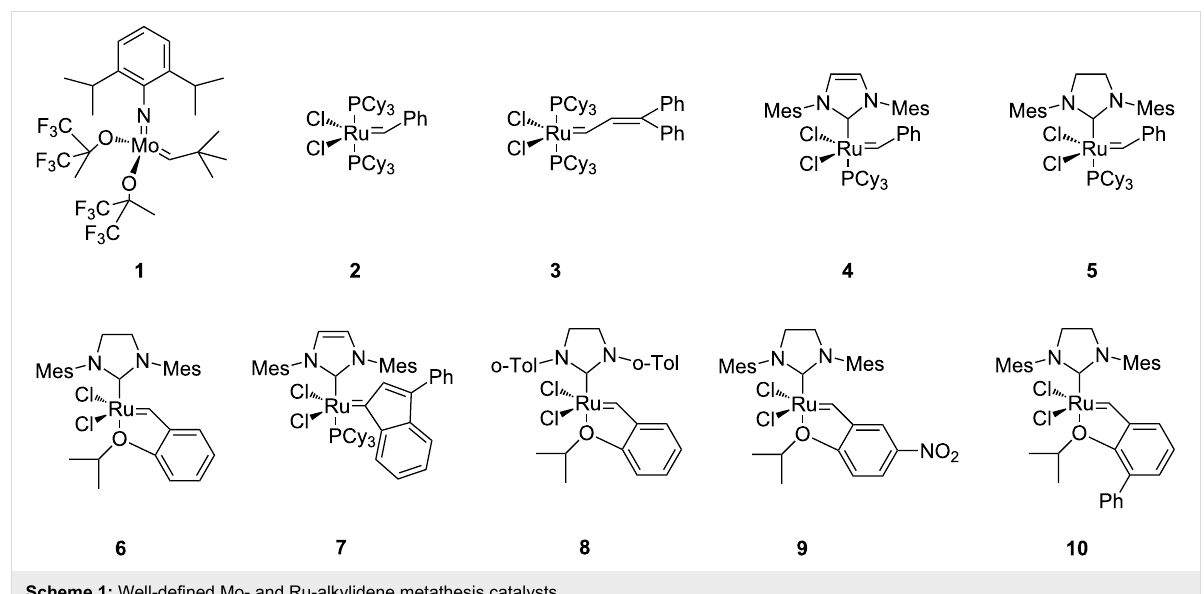
Scheme 1: Well-defined Mo- and Ru-alkylidene metathesis